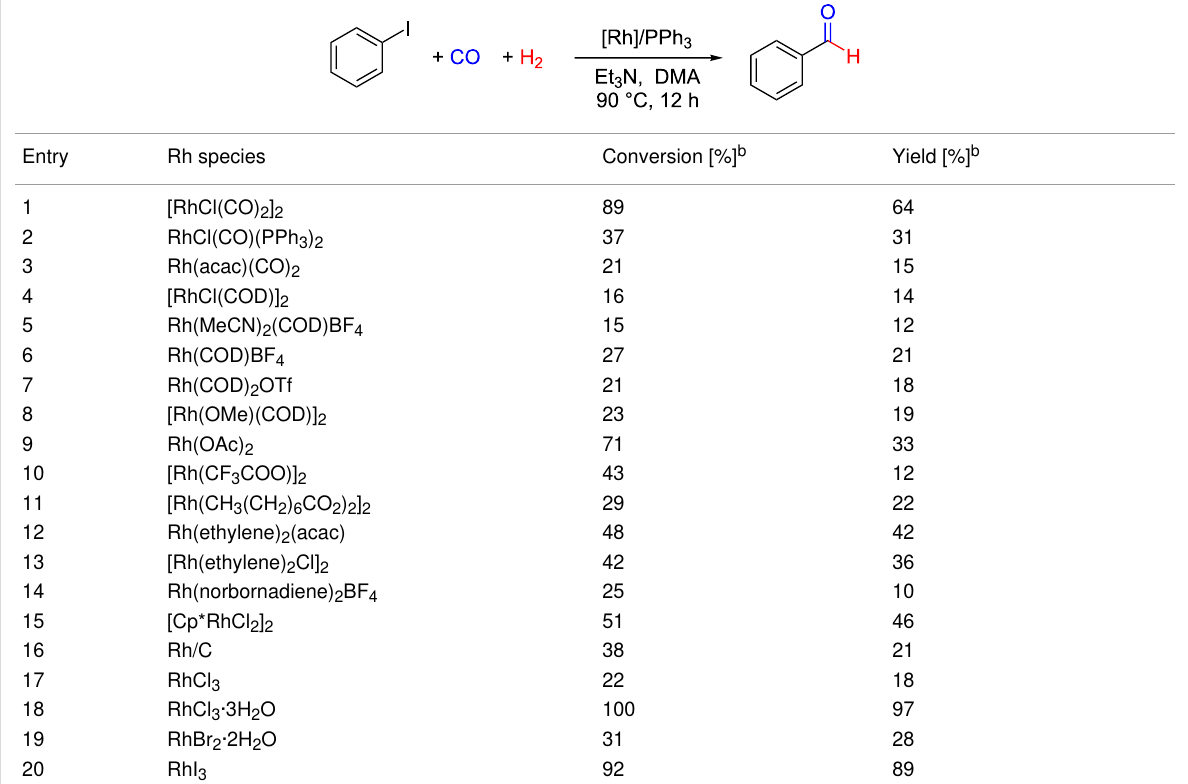
Table 1: Rhodium-catalyzed reductive carbonylation of iodobenzene with CO and H 2 to afford benzaldehyde: effects of the Rh species a